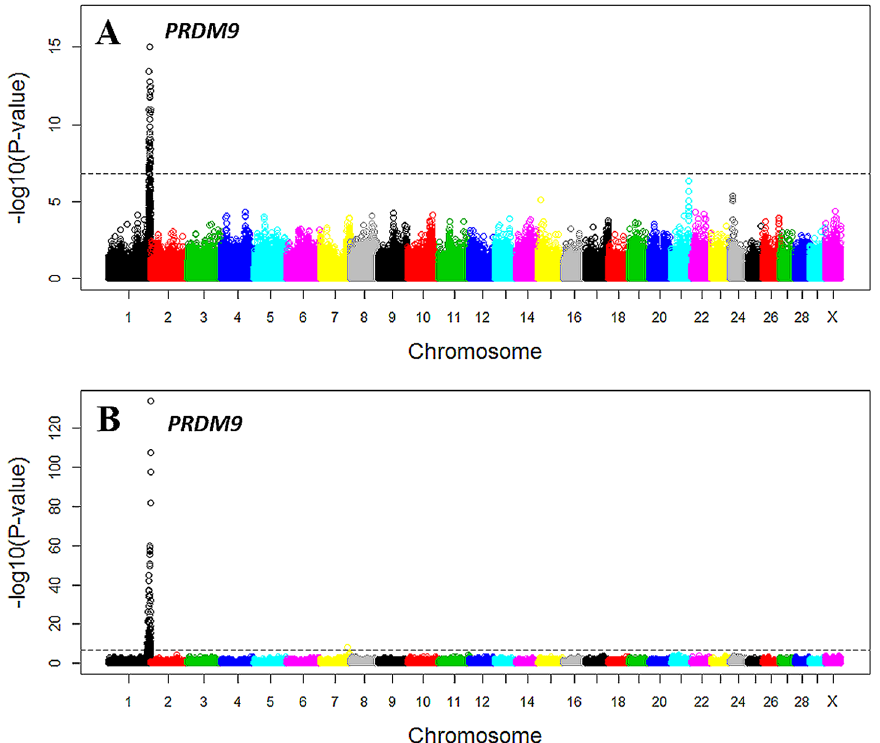
Fig 6. Manhattan plot of the GWAS of genome-wide hotspot usage for males (A) and females (B). Different colors were used to distinguish the 29 chromosomes. The genome-wide significance level of 1.6×10 − 7 was shown by the horizontal dotted line. USDA-AGIL SNP coordinates were used for plotting, which placed PRDM9 -linked SNPs to the end of Chromosome 1. Note that UMD3.1 assembly placed PRDM9 near the middle of Chromosome